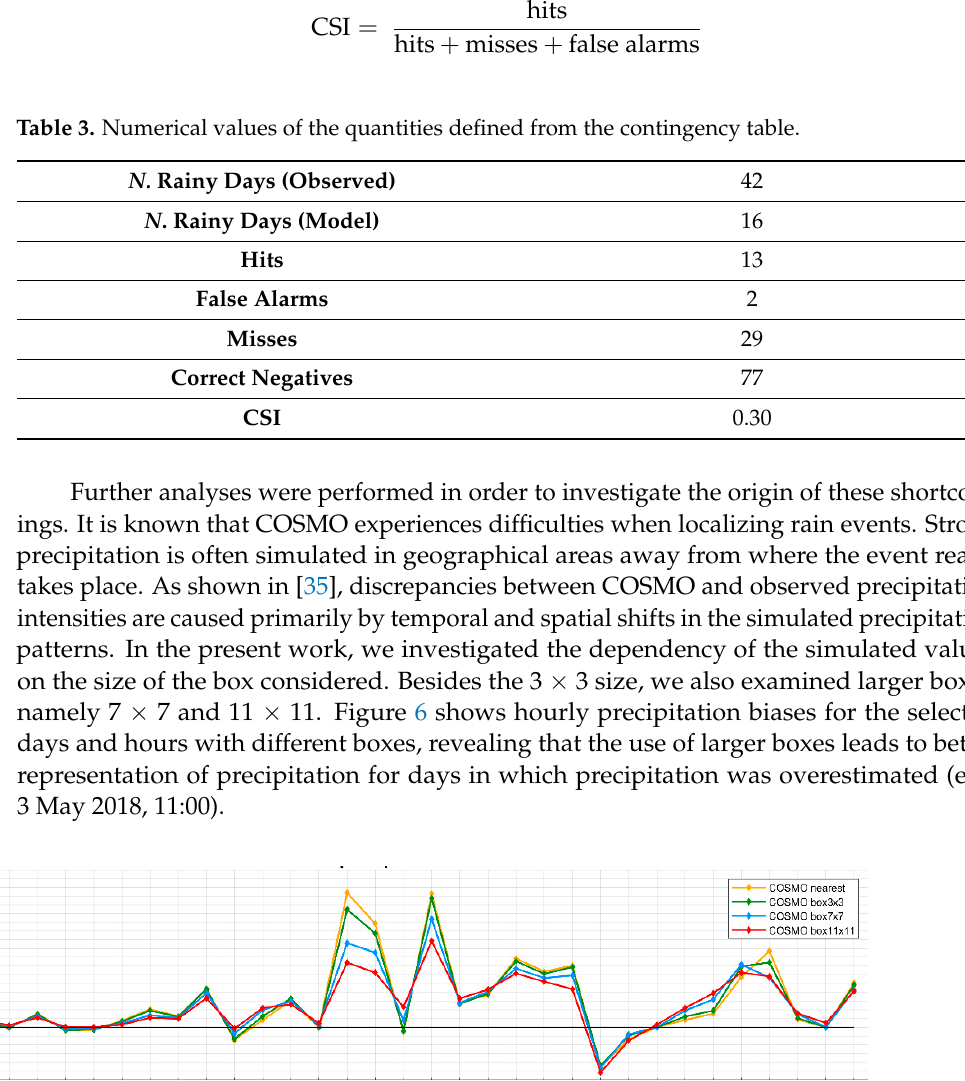
Figure 5. Histogram of daily precipitation values (mm) at the CIRA site over the considered period: observational and model data for the nearest grid point and grid box. Table 2. Contingency table and related definitions.